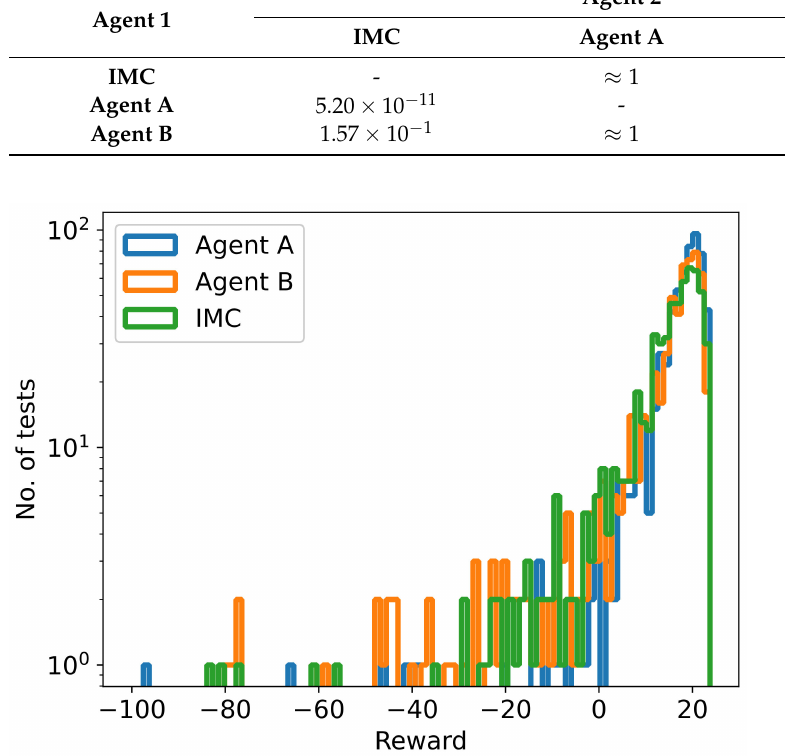
Figure 7. Histogram of test rewards for Agents A and B, compared to IMC. Tests with rewards lower than − 100 have not been